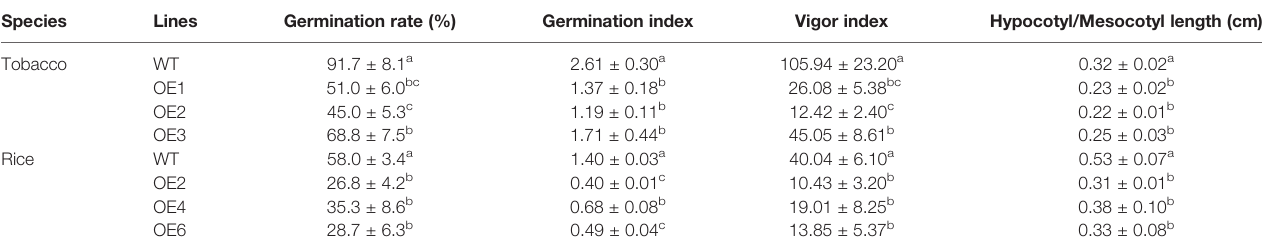
WT and OE represent wild-type and ZmMYB59 transgenic plants, respectively. Means with standard deviations that do not followed by the same lower case letter between OE and WT lines signi fi cantly differ by ANOVA analysis at 5% level of signi fi cance. Three replicates of twenty seeds each were used for germination test.